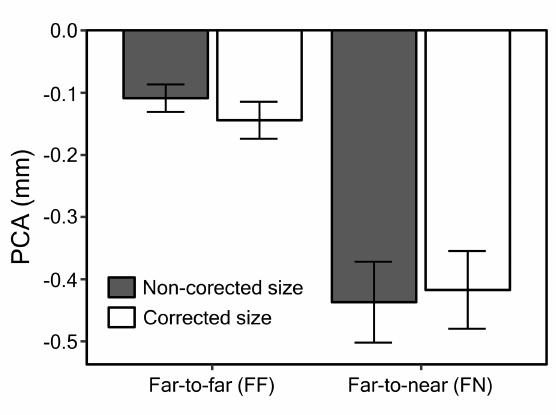
Figure 4. Mean pupil constriction amplitudes (PCAs) of experi- ment 1, together with standard errors.